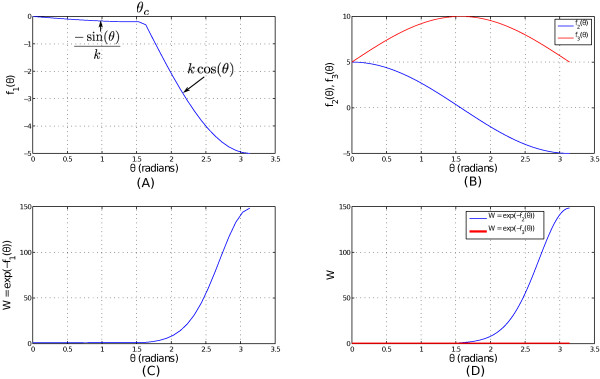
Influence ofθ on the values of functionsf1,f2,f3 and their correspondingW.(A) Variation of f1(θ) with θ. (B) Variation of f2(θ) and f3(θ) with θ. (C)W corresponding to sub-figure (A). (D)W corresponding to sub-figure (B).